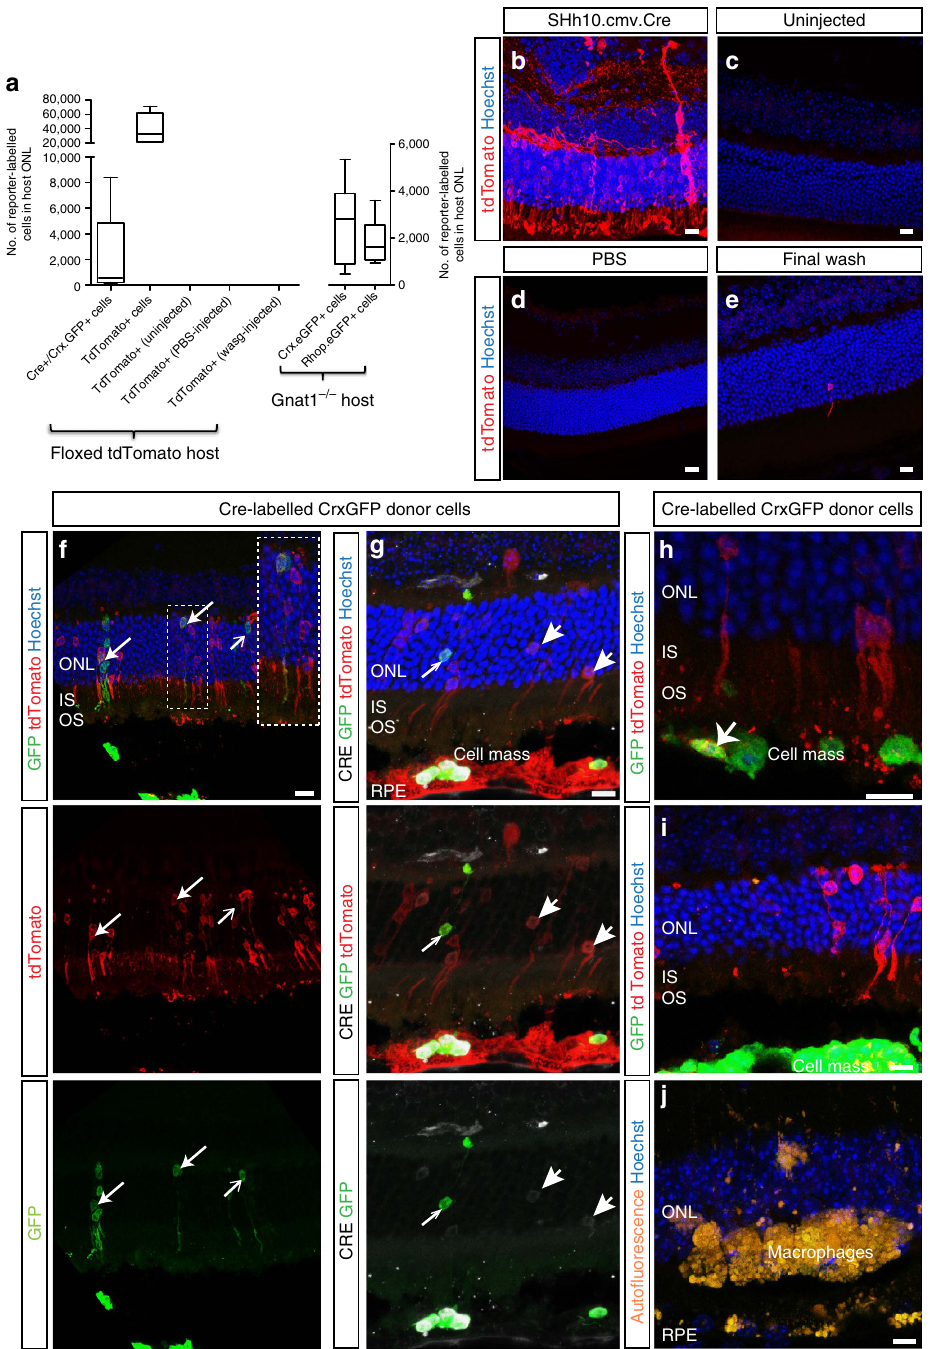
Figure 9 | Transplantation of Cre þ photoreceptor precursors leads to widespread expression of floxed reporters in host cells. ( a ), box (25–75% percentile) and whiskers ( min /max) plot showing median (line) number of reporter-labelled photoreceptors in adult dTomatofloxed host retinae following transplantation. ** P o 0.01 2-way ANOVA. N.B. all controls (uninjected, PBS-injected and final wash) were highly significantly different from both Cre þ /GFP þ and TdTom þ populations but are not denoted on graph for clarity). ( b – d ), confocal projection images showing retinal sections after sub-retinal injection of ( b ) ShH10.CMV.iCre (5 (cid:3) 10 12 viral particles per ml (cid:2) 1 ), ( c ) uninjected, ( d ) PBS-injected, or ( e ) mice injected with final wash from cell preparation. ( f ), confocal projection images of GFP þ ( green ) and tdTomato þ ( red ) cells within the floxed tdTomato host retinae following transplantation of Crx.GFP þ /Cre þ donor cells. Note that there are significantly higher numbers of tdTomato þ cells than GFP þ cells. Inset , example of